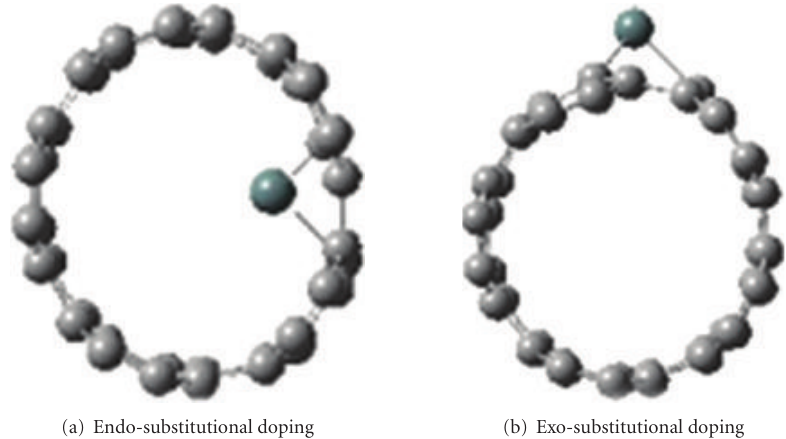
Figure 10: Two geometries of substitutional doping, namely (a) endo - and (b) exo-substitution. [110].